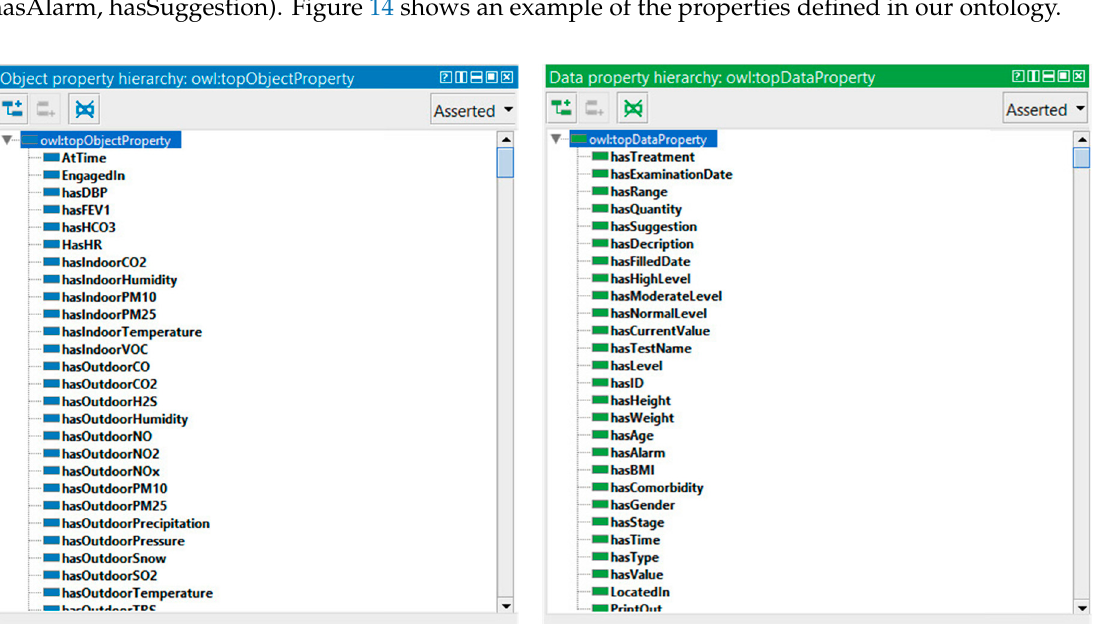
Figure 14. Part of datatype and object property.